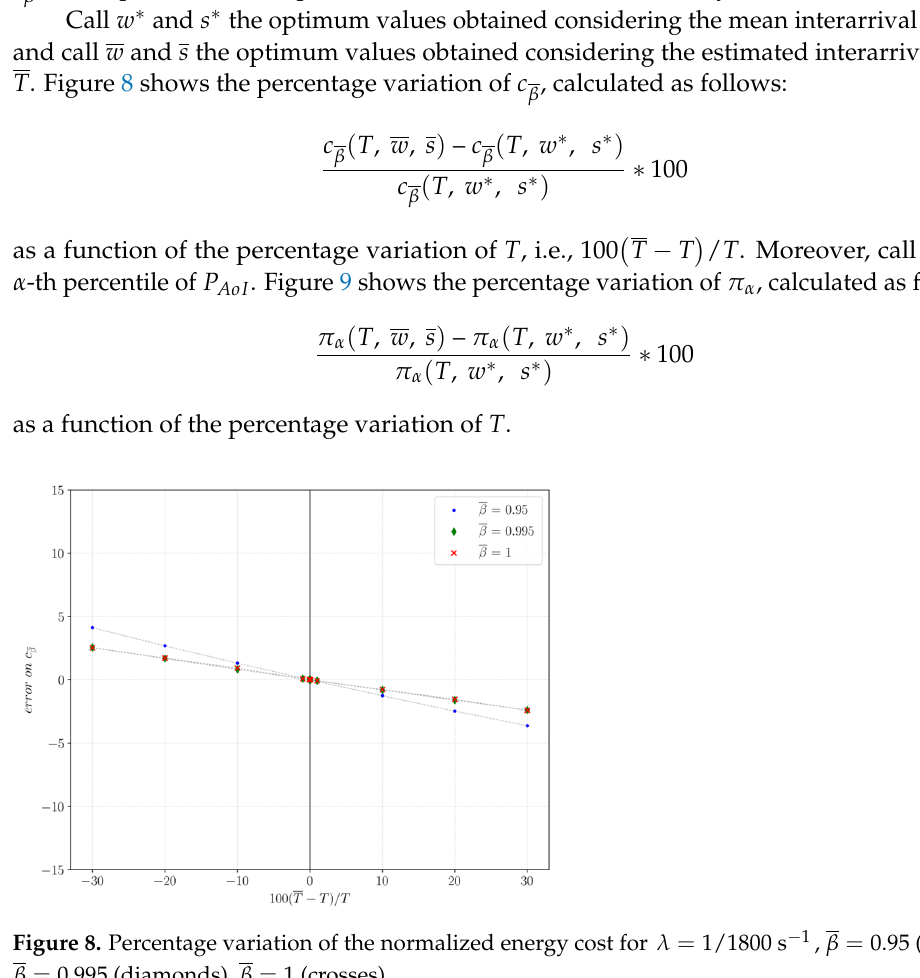
Figure 9. Percentage variation of 𝐴𝑜𝐼 (cid:3080) for 𝜆 = 1 (cid:3403) 1800 s (cid:2879)(cid:2869) , 𝛽̅ = 0.95 (circles), 𝛽̅ = 0.995 (diamonds), 𝛽̅ = 1 (crosses). From Figure 8 we can notice that when 𝑇 is underestimated, the resulting energy consumption cost is larger than the minimum value, though the variation is small. On the other hand, when 𝑇 is overestimated, the energy consumption is smaller, but the AoI requirement is not satisfied (see Figure 9). However, for small variations of 𝑇 , the percentage variation of 𝜋 (cid:3080) is small.